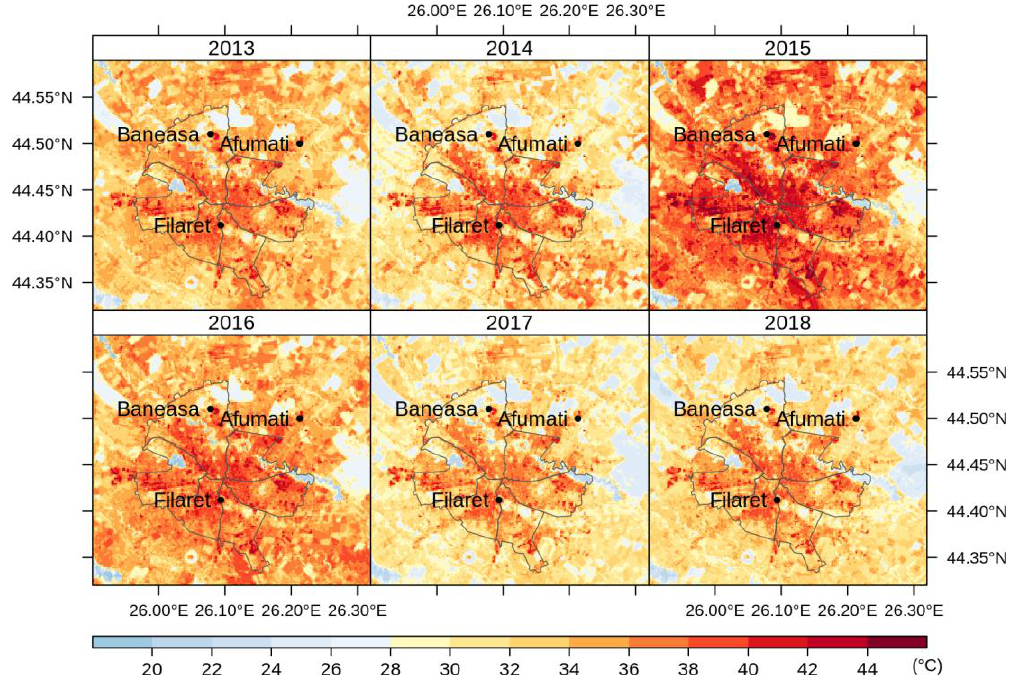
Figure 10. Average summer LST values (°C) over Bucharest retrieved from JJA Landsat 8 imagery (2013–2018).